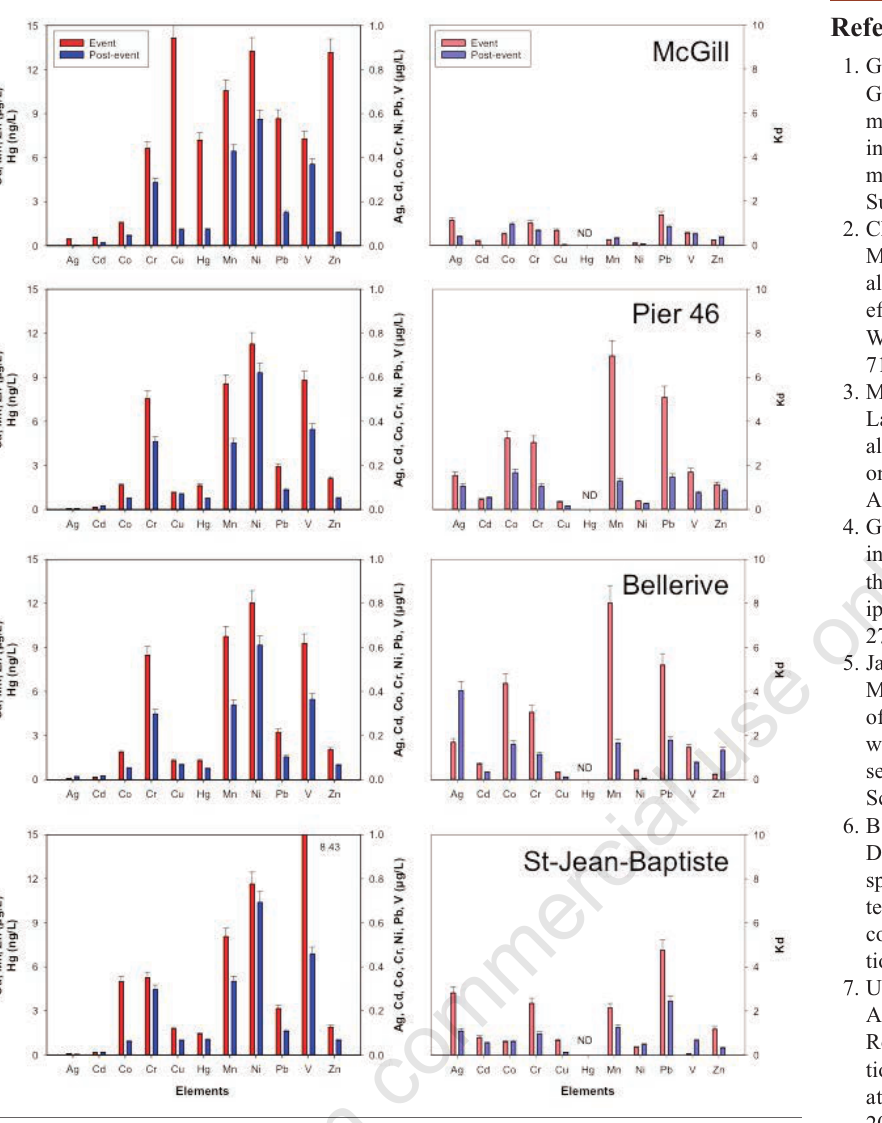
Figure 2. Total metal concentrations (left) and partitioning coefficient Kd (right) at dis- charge points during and after the event.